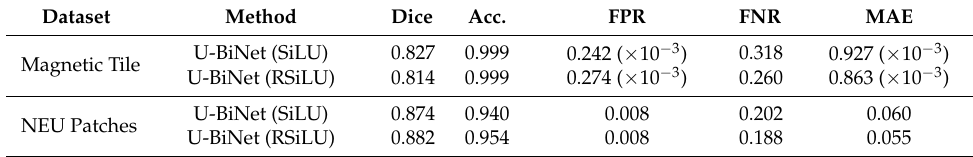
Table 7. Ablation study on RSiLU. All the activations are full-precision